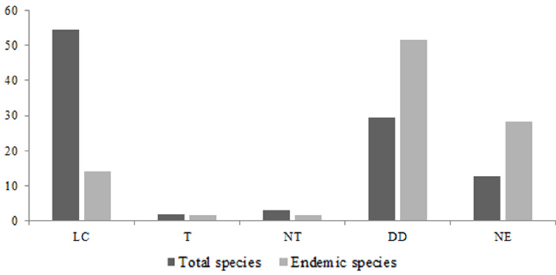
Figure 2 - Percentage of species in each conservation status according to the IUCN Red list (2016). Dark gray bars indicate the total species recorded (n=182); Light gray bars indicate endemic species to the Serra da Canastra, South of Espinhaço and the Mantiqueira complex (n=64). LC = Least concern; T = under some degree of threat (Critically Endangered, Endangered, Vulnerable); NT = Near Threatened; DD = Data deficient; and NE = not